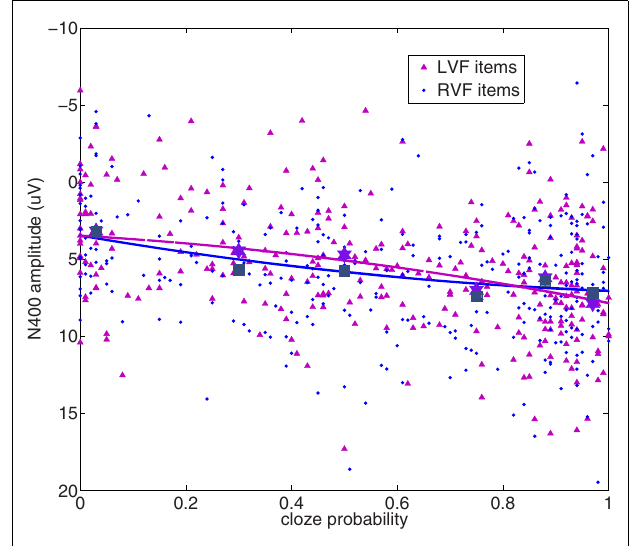
FIGURE 3 | Item-level N400 amplitudes (averaged across participants) plotted against cloze probability for all items in eachVF. Grand mean amplitudes for the 6 cloze bins described in the Method section are overplotted (dark blue squares: RVF/LH; purple stars: LVF/RH) along with the predicted response functions from the hierarchical